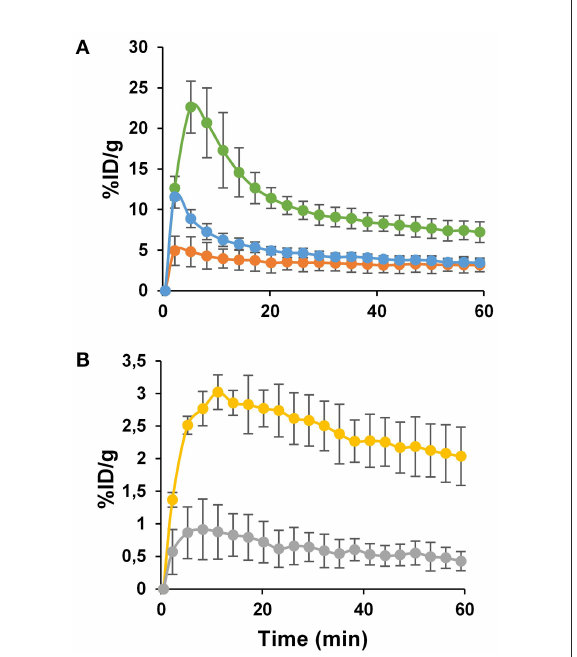
FIGURE4 The kinetics of PET image-derived uptakes (%ID/g) ± SD in kidney ( A , green line), liver ( A , orange line), blood ( A , blue line), tumor ( B , yellow line), and muscle ( B , gray line) measured during 1h dynamic scan. Each data point represents the average values for 7 nude mice.